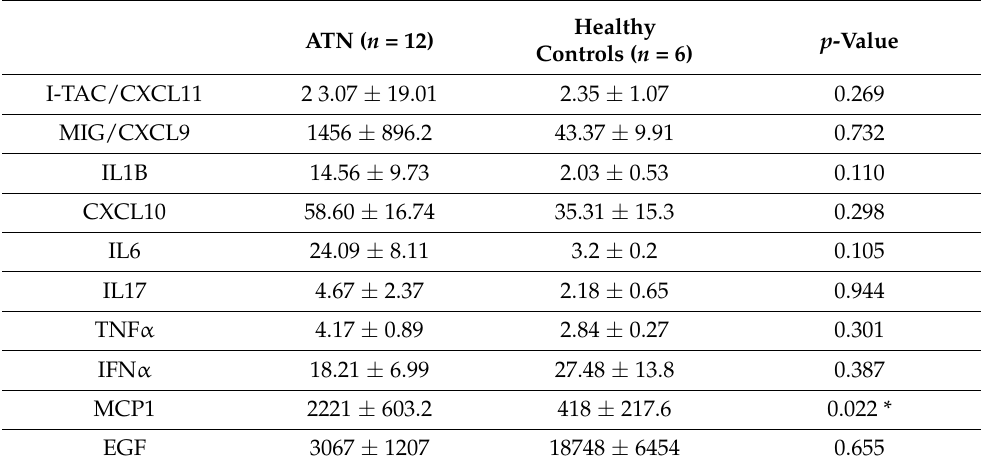
Table 5. Comparison of the urinary concentration of the evaluated cytokines in patients with ATN and healthy controls. * Statistically significant differences. ATN—acute tubular necrosis. ATN ( n =